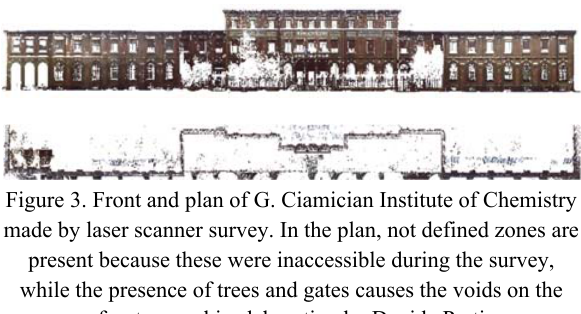
front – graphic elaboration by Davide Prati